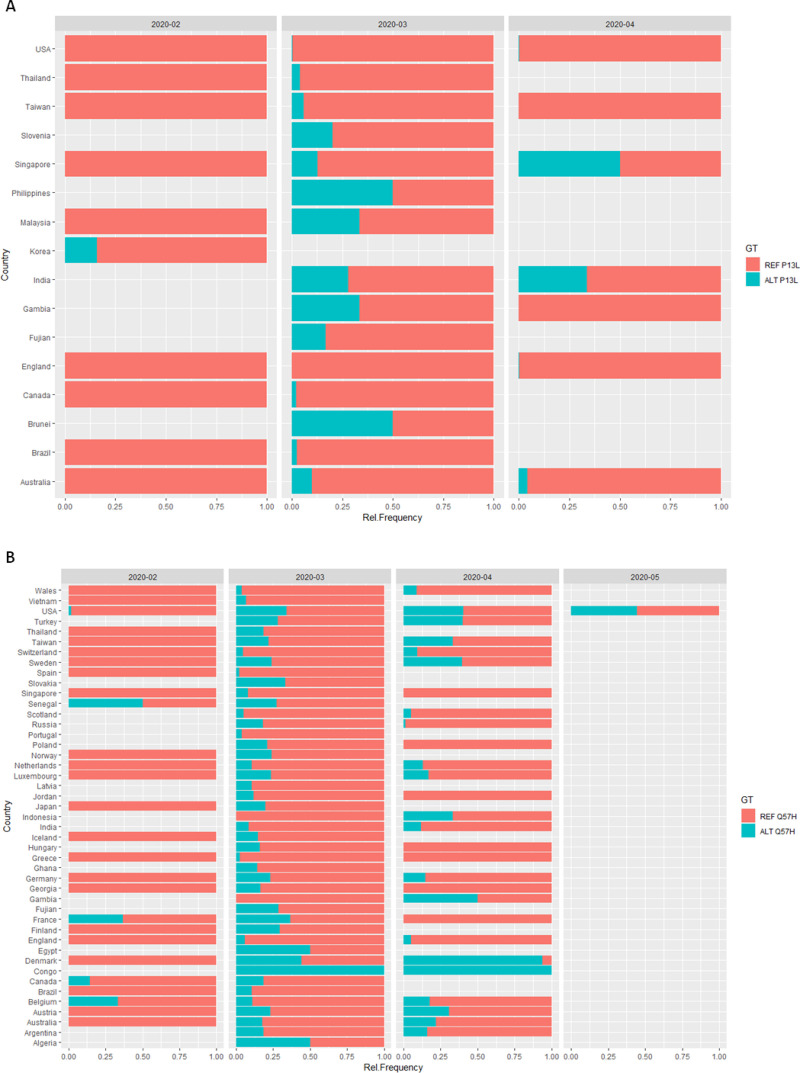
Mutation tracking relative frequency plots.A. P13L transmission in months from its first occurrence in Asia (Korea) to its transmission across other countries and continents. B. Q57H transmission in months from its first occurrence in Europe (France) to its transmission across the globe.